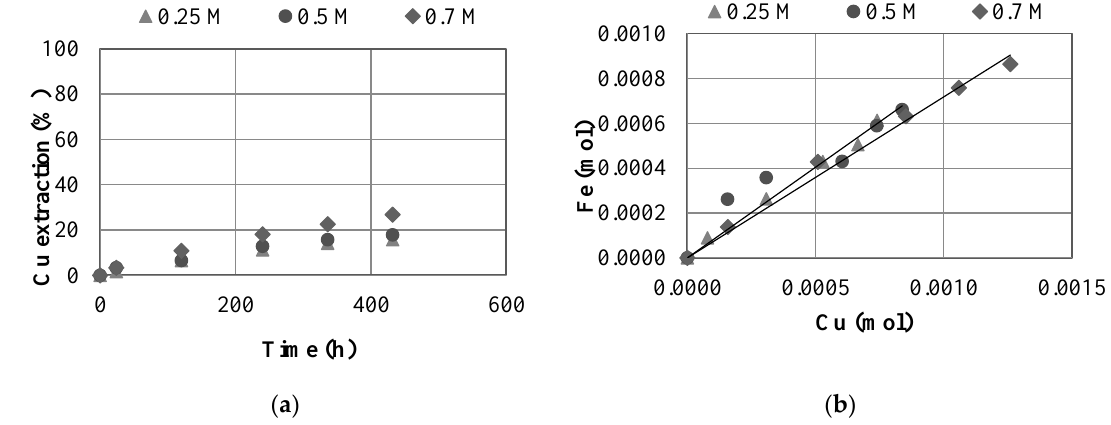
Figure 6. ( a ) Copper extraction (%) versus time (h) at different sulfuric acid concentration: 0.25, 0.5 and 0.7 M. ( b ) Cu/Fe molar ratio at different sulfuric acid concentration: 0.25, 0.5 and 0.7 M. Experimental conditions: [NaNO 3 ] = 0.7 M, seawater as dissolvent, −150 + 75 µm, S/L ratio 2 g/L, 45 °C, 350 rpm, sample A.